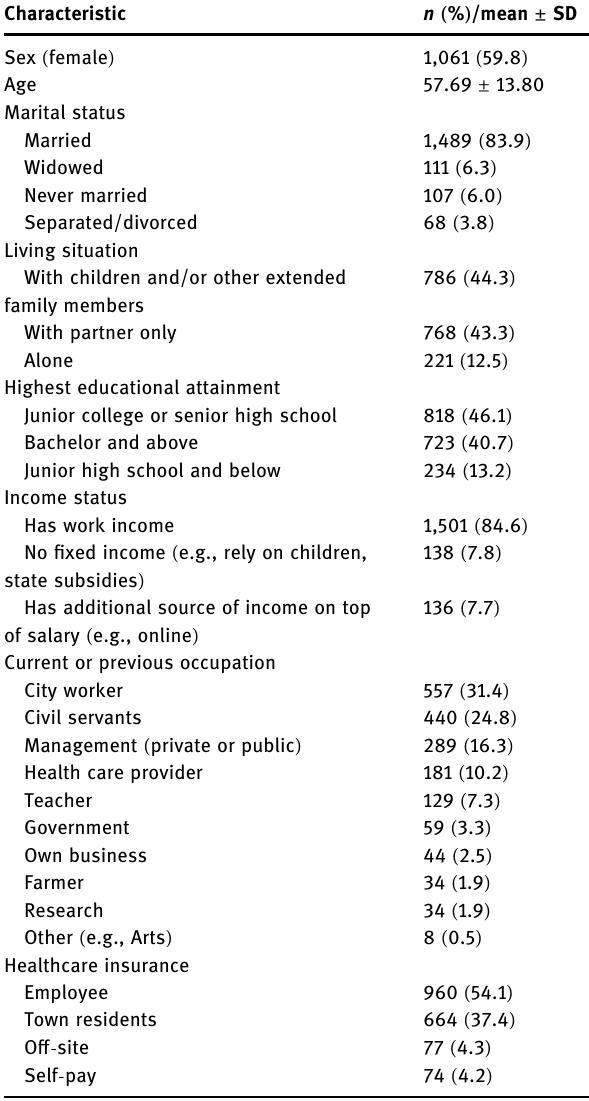
Table 1: Participant sociodemographic characteristics ( N = 1775 )